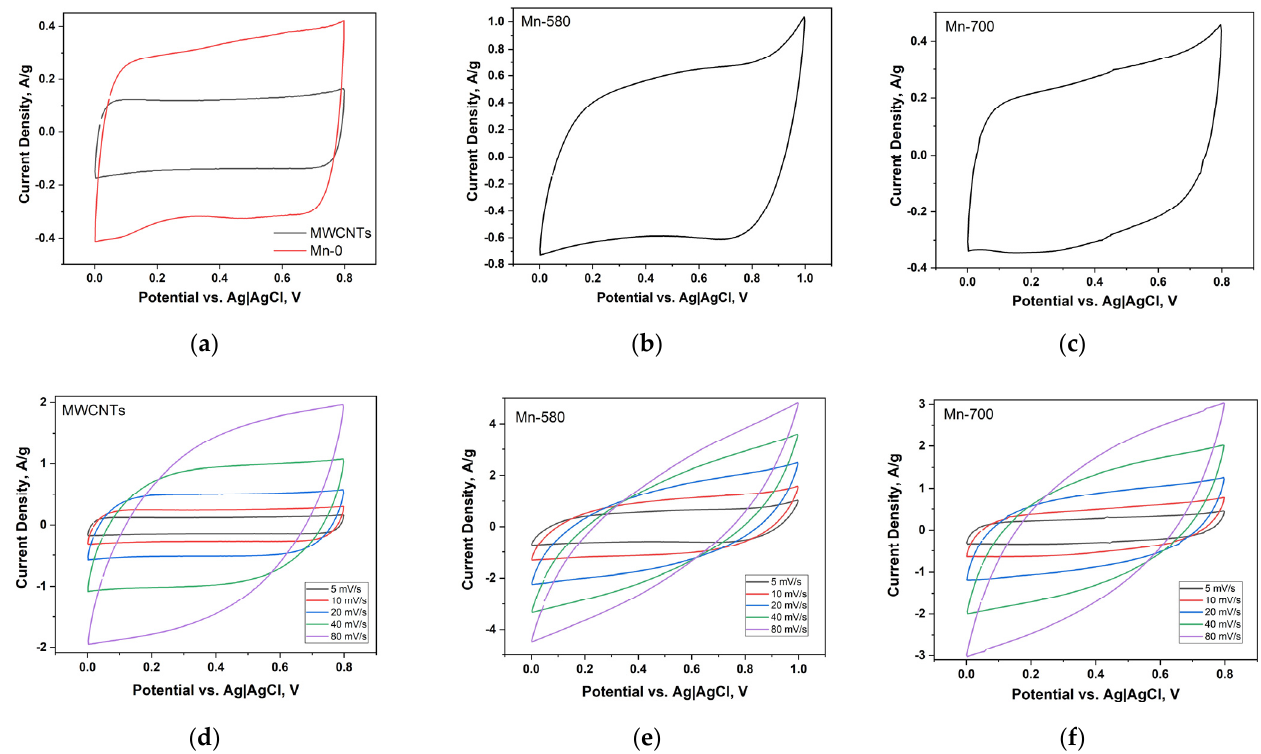
Figure 6. CV curves of electrodes based on MWCNTs and Mn-0, measured at a potential scan rate of 5 mV/s ( a ); CV curve of the electrode Mn-580 ( b ); CV curve of the electrode Mn-700 ( c ); CV curves measured at different potential scan rates for electrodes based on MWCNTs ( d ), Mn-580 ( e ) and Mn-700 ( f Table 4. Specific capacitance ( Cs ) versus potential scan rate for MWCNTs and composites. 348 Sample